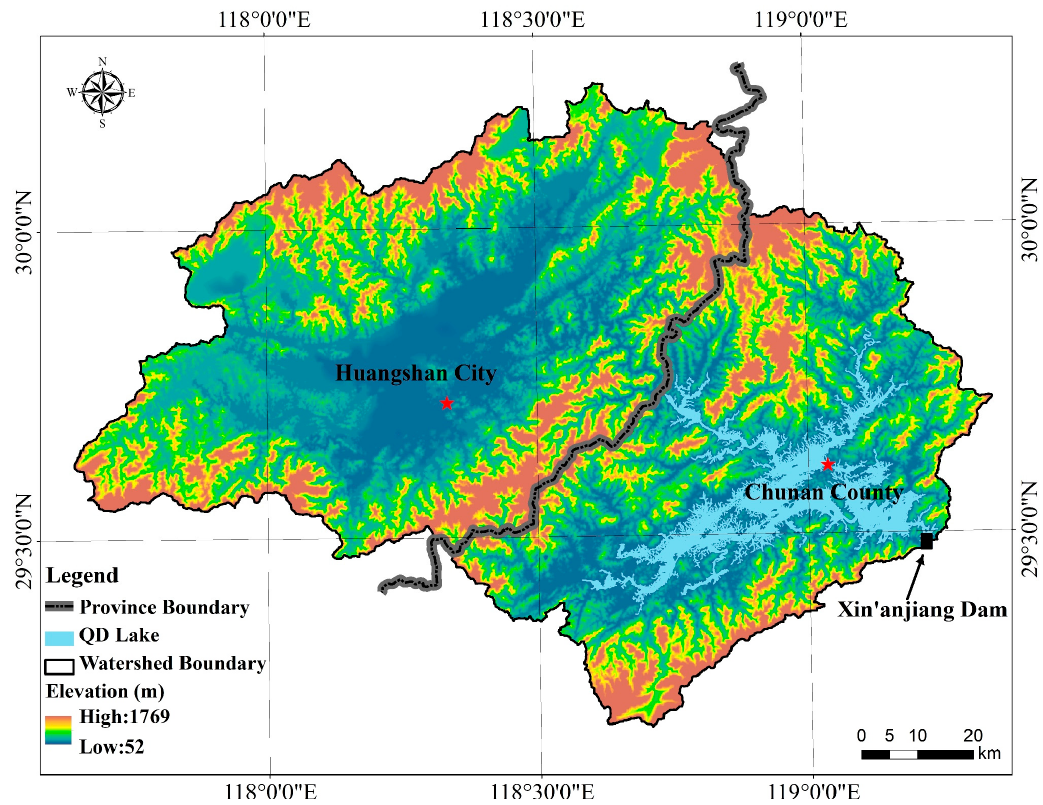
Figure 3. The Qiandao Lake watershed. The dark line separates Anhui Province on the left from Zhejiang Province on the right.